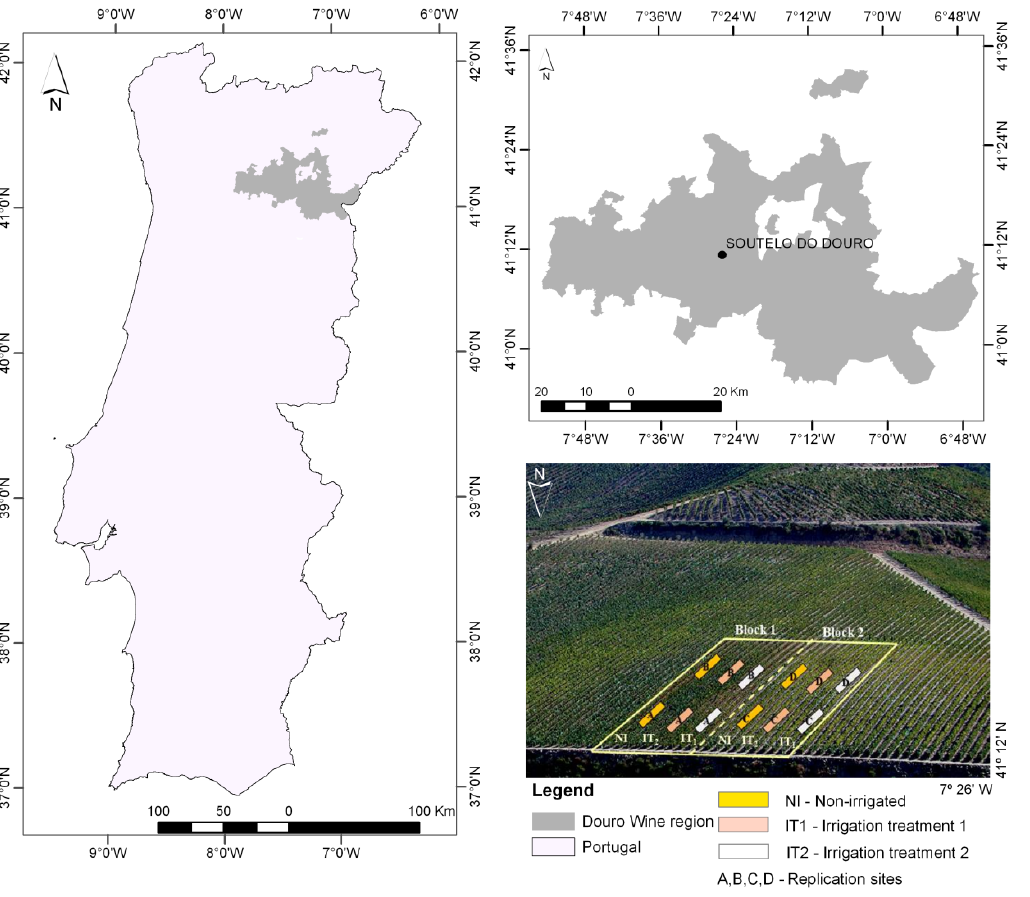
Figure 1. Location of the study area in the Douro Wine Region, Northeast Portugal, and identification of the experimental plot, with Blocks 1 and 2, and irrigation treatment